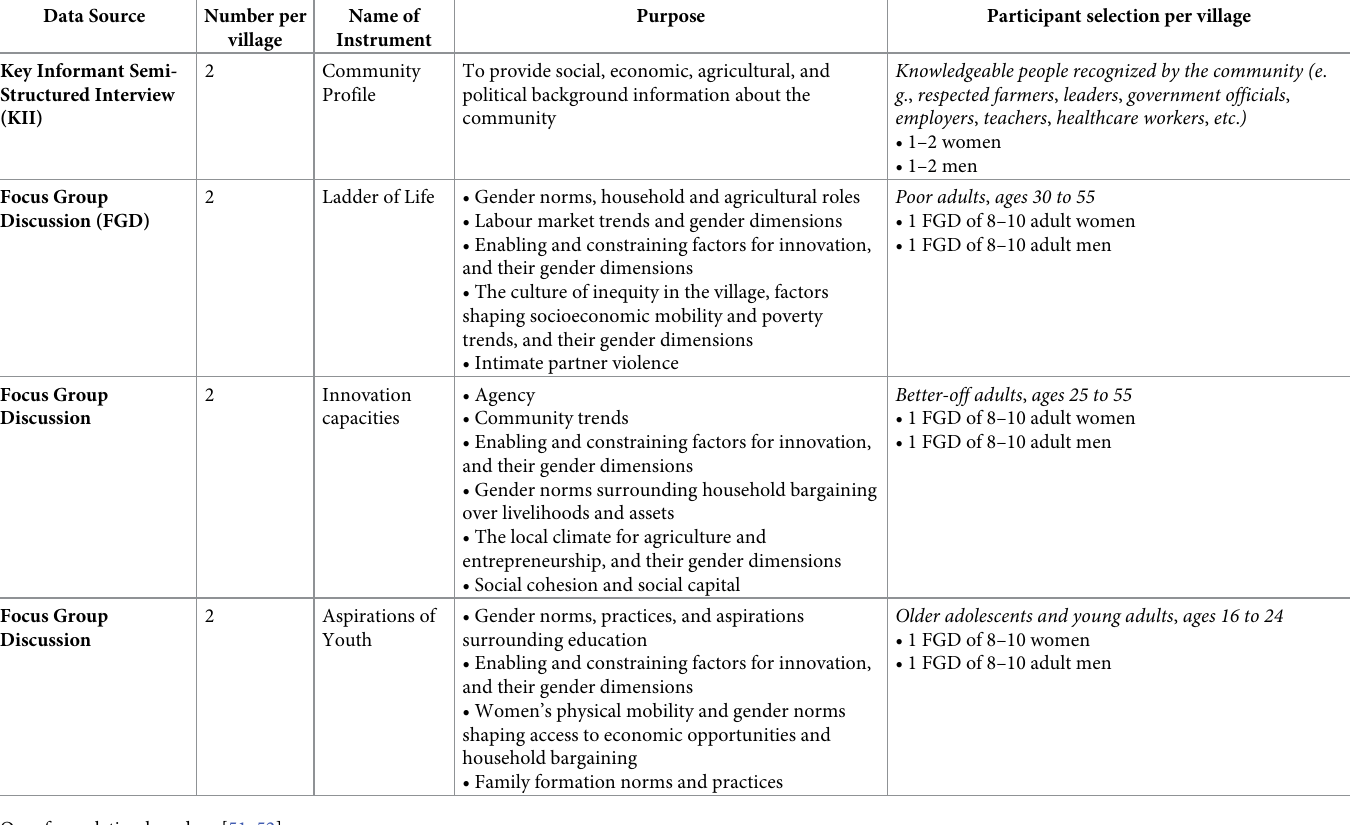
Table 1. Sources of